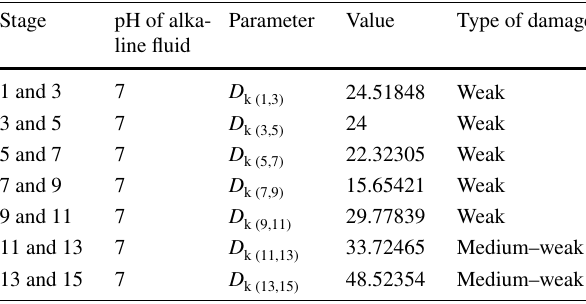
Table 6 Determination of the degree of formation damage ( D core no. 3